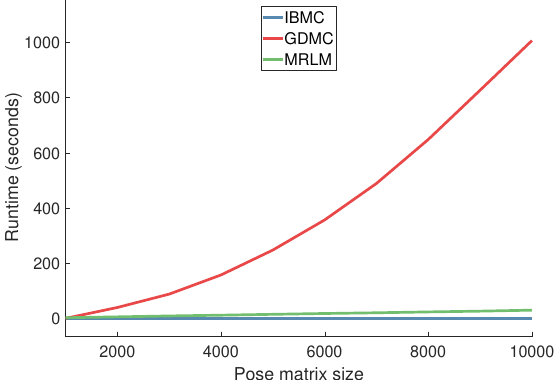
Figure 14. Same as Figure 13 but for pose matrices of sizes in the range 1000 to 10,000, so as to illustrate the quadratic complexity of